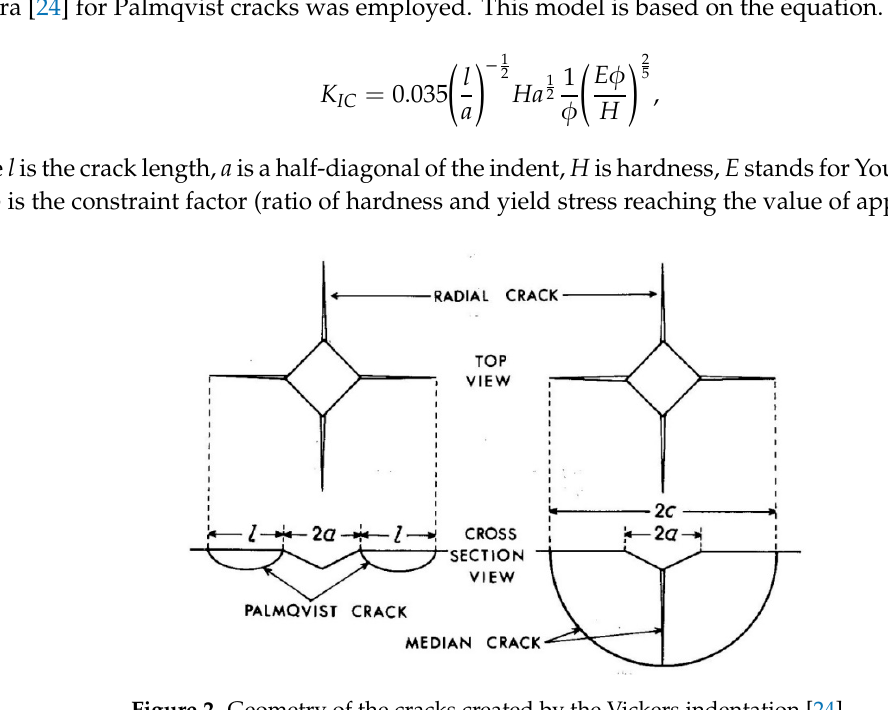
Figure 2. Geometry of the cracks created by the Vickers indentation [24].